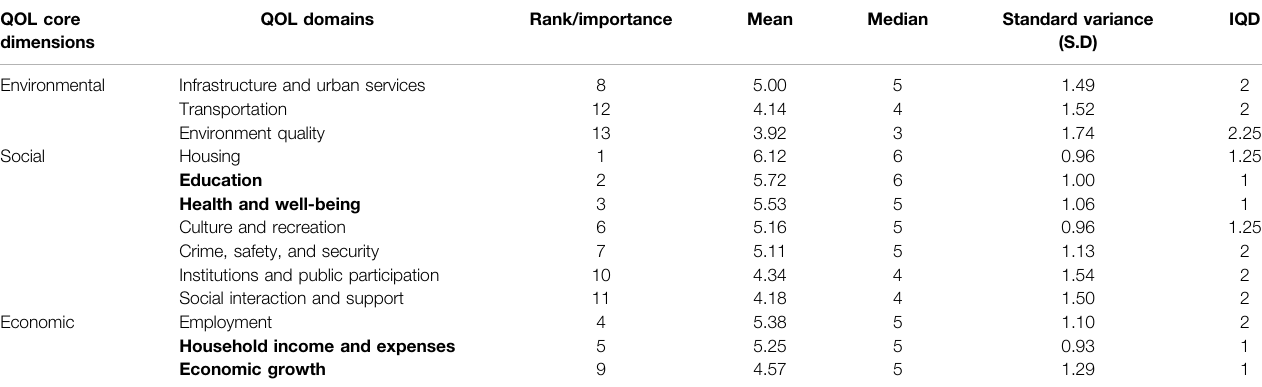
TABLE 7 | Rating of the importance of the 13 domains and the consensus